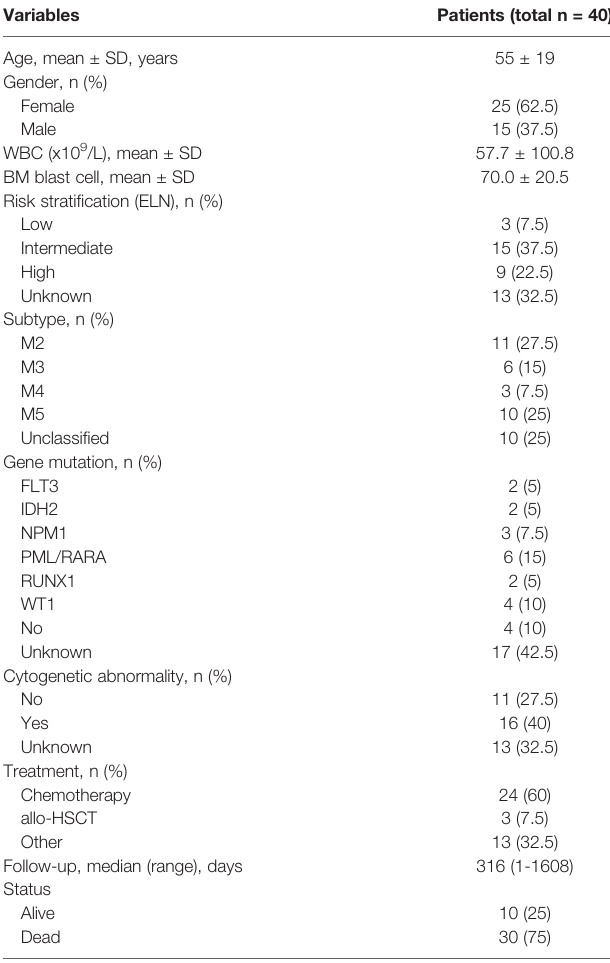
TABLE 1 | Clinical characteristics of AML patients.